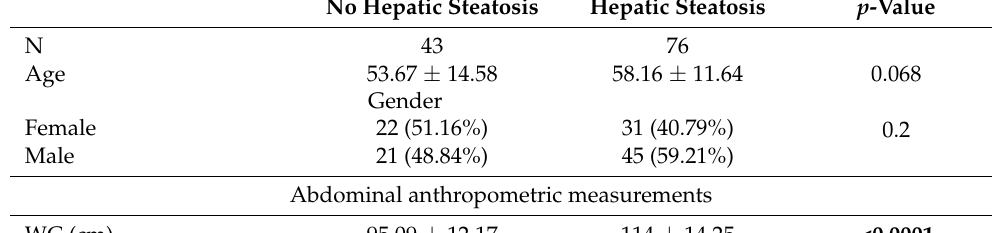
Table 1. Comparison between individuals with and without liver steatosis. No Hepatic Steatosis Hepatic Steatosis p